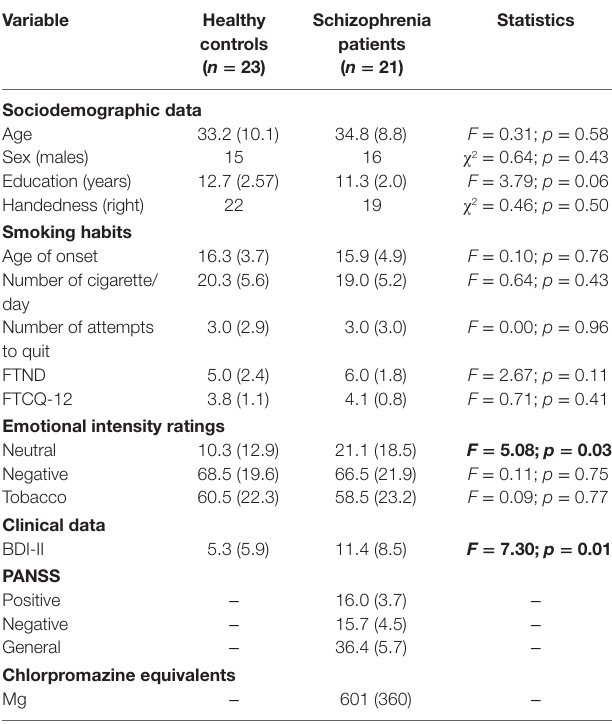
TaBle 1 | Demographical, clinical, and behavioral data.